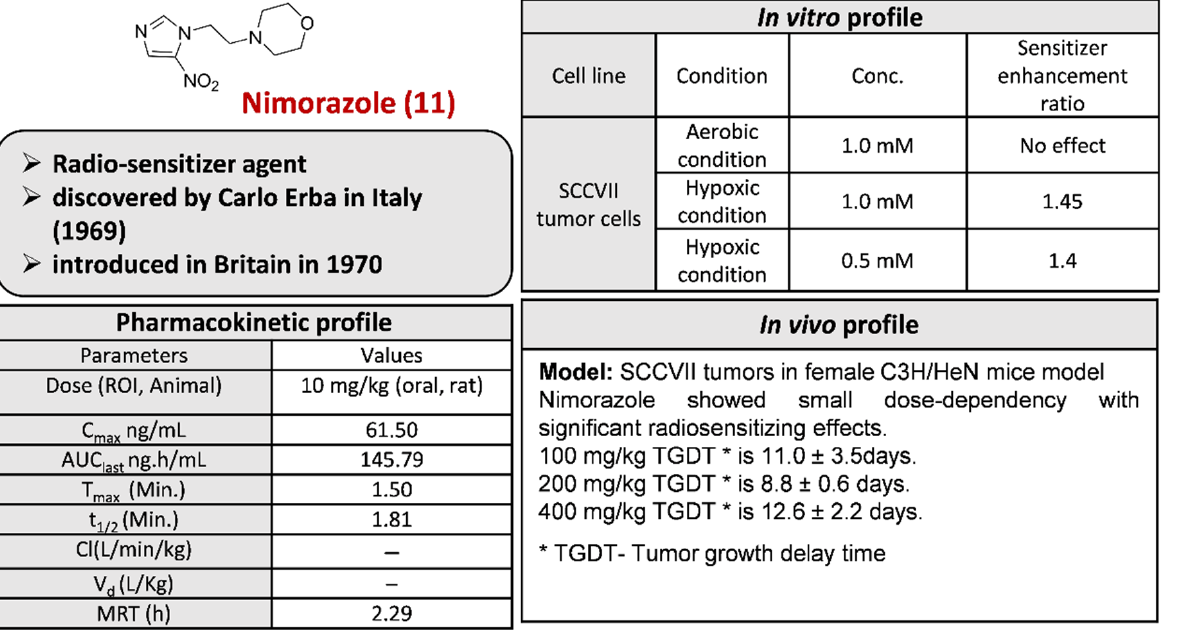
Figure 15. Activity profile of Nimorazole 11 [125,126]. *: TGDT – Tumor Growth delay time.